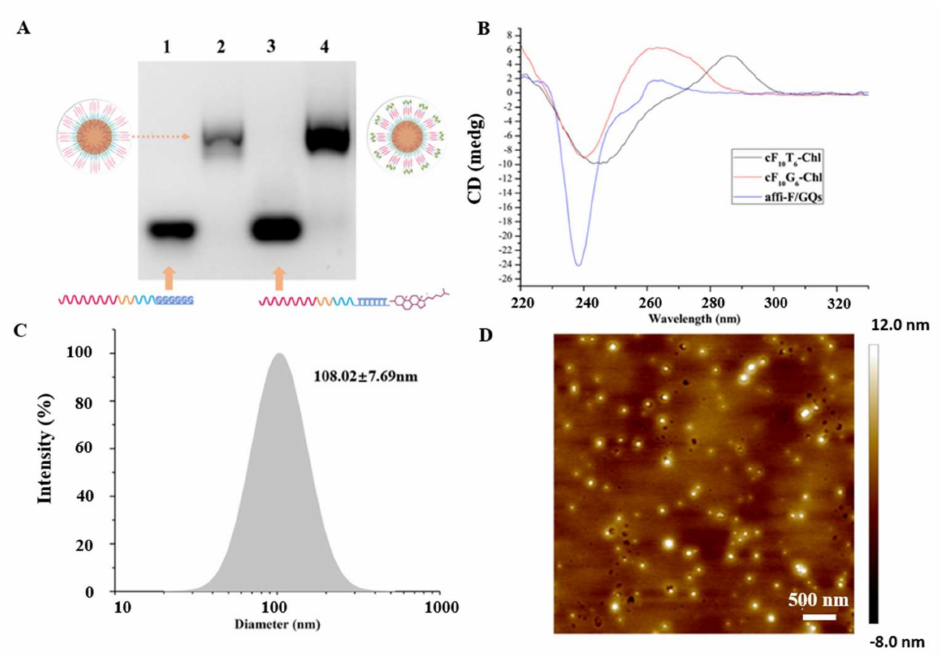
Figure 2. ( A ) Self-assembly of G-quadruplex DNA micelles were assayed by 2% agarose gel. (Lane from left to right: cF 10 G 6 , cF 10 G 6 -Chl, cF 10 T 6 -Chl and affi-F/GQs). ( B ) CD spectra of cF 10 G 6 -Chl, cF 10 T 6 -Chl and affi-F/GQs. ( C ) Size distribution of affi-F/GQs. ( D ) AFM image of